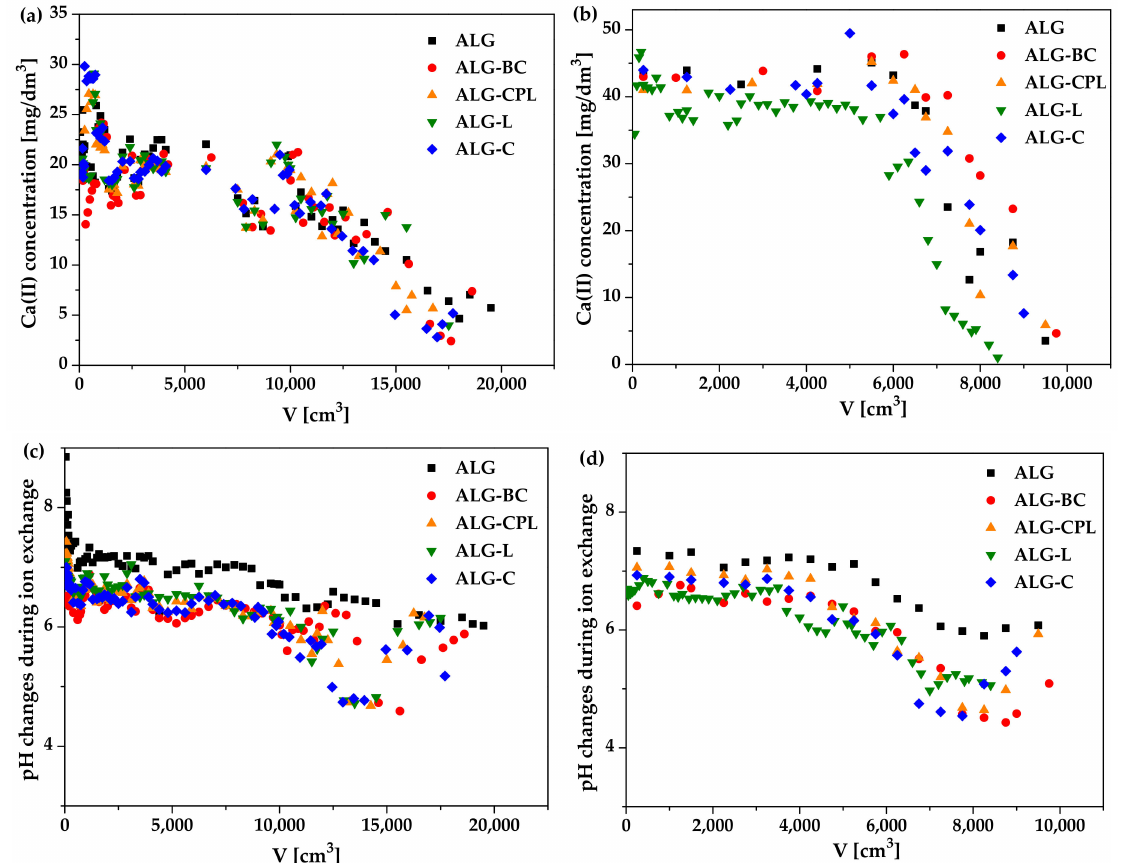
Figure 6. Changes in the Ca(II) ion concentration and solution pH during the ion exchange onto the alginate-based adsorbents for ( a , c ) 50 mg/dm 3 as well as ( b , d ) 100 mg/dm 3 of